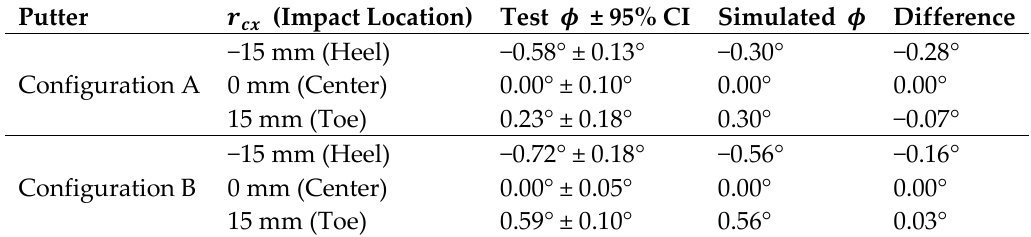
Table 1. Test results of putter configuration 1 and putter configuration